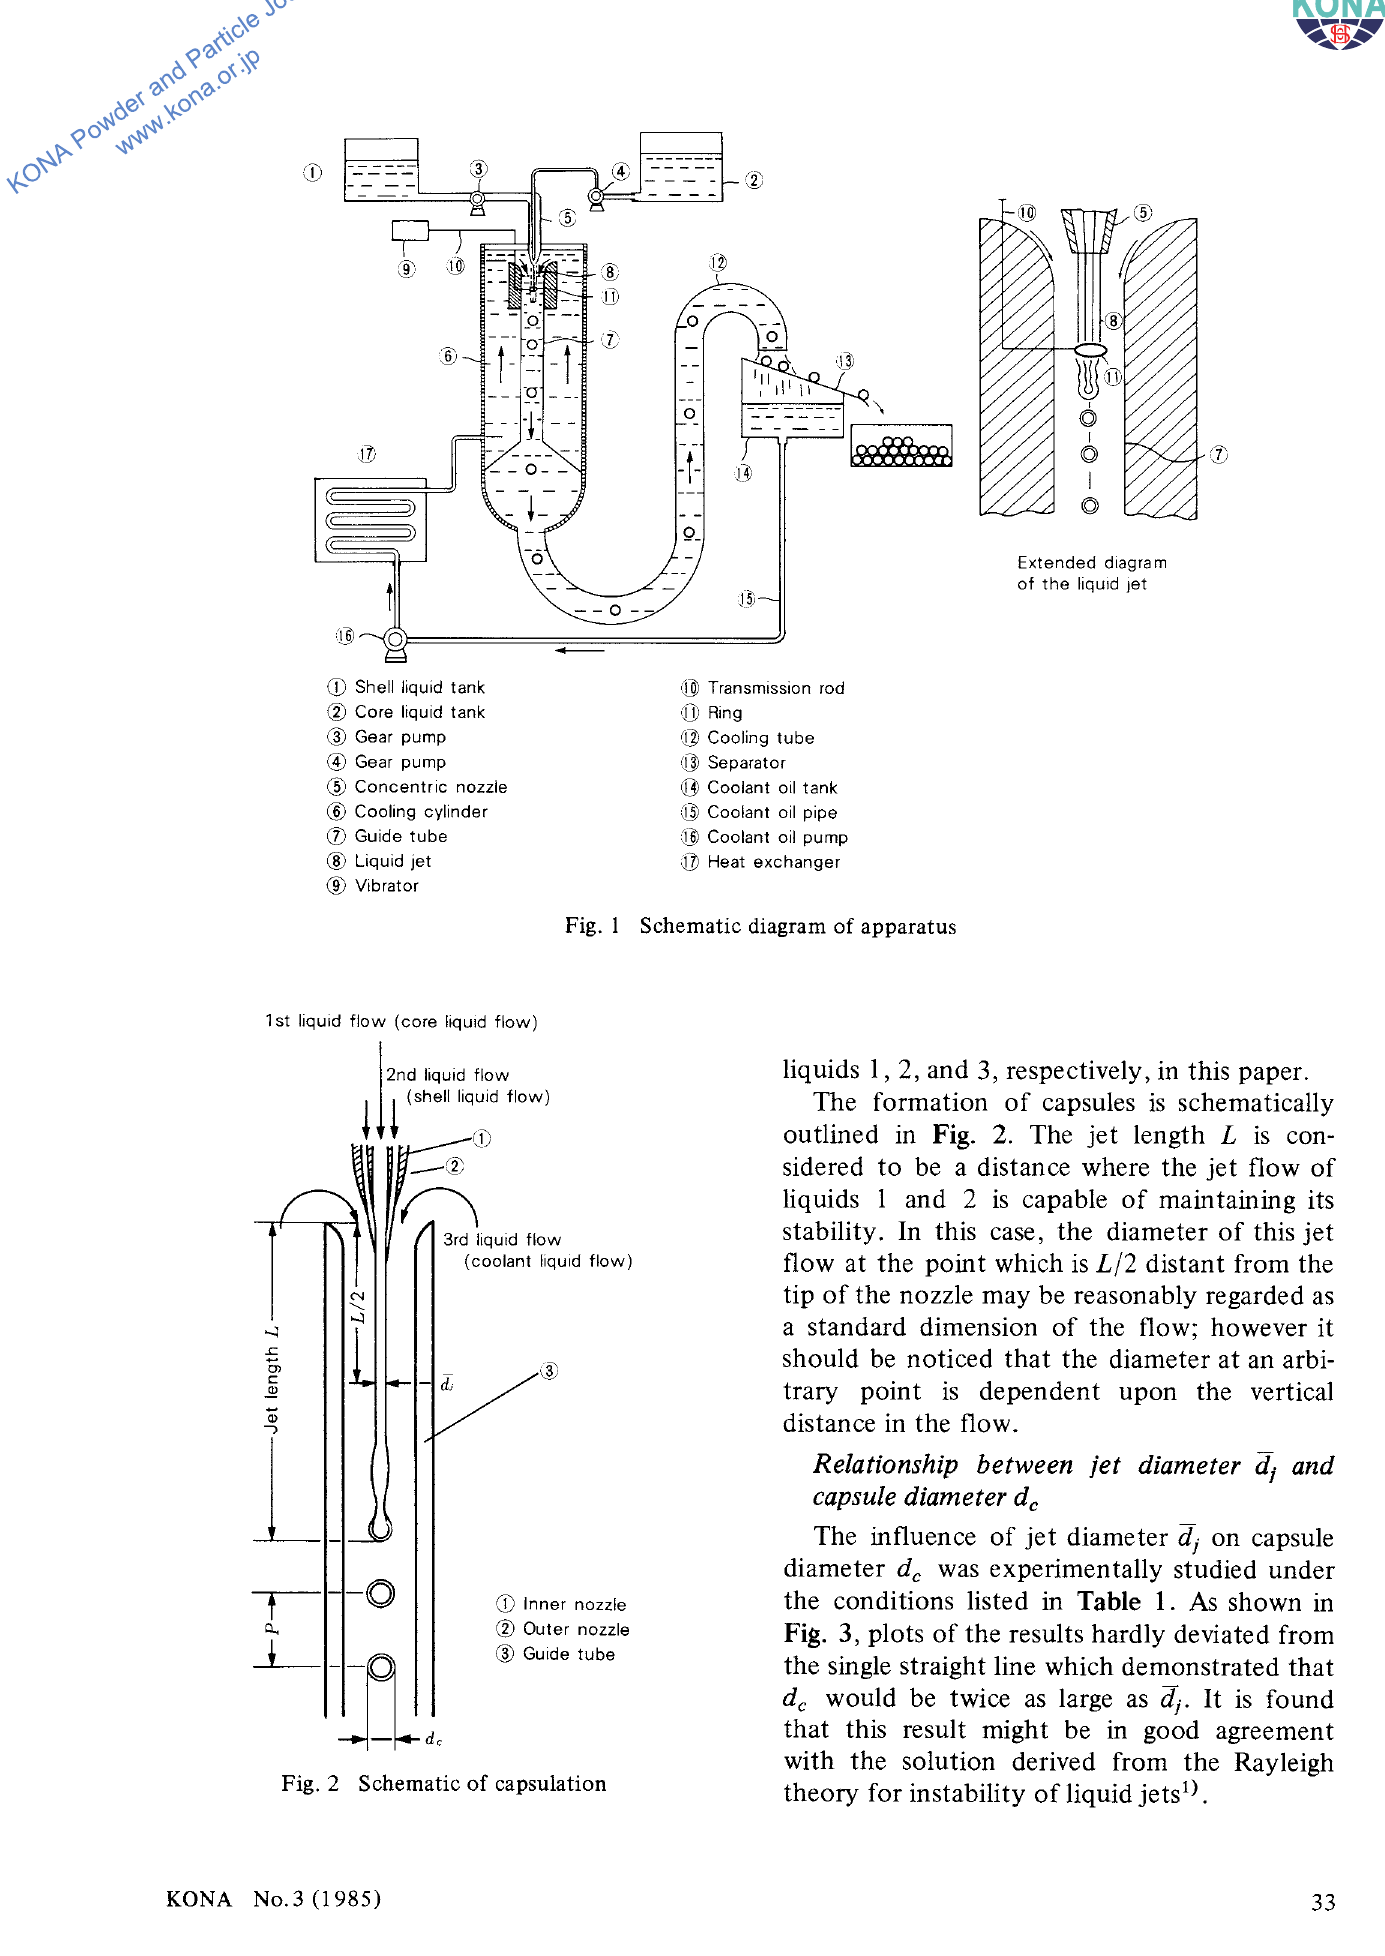
Fig. 2 Schematic of